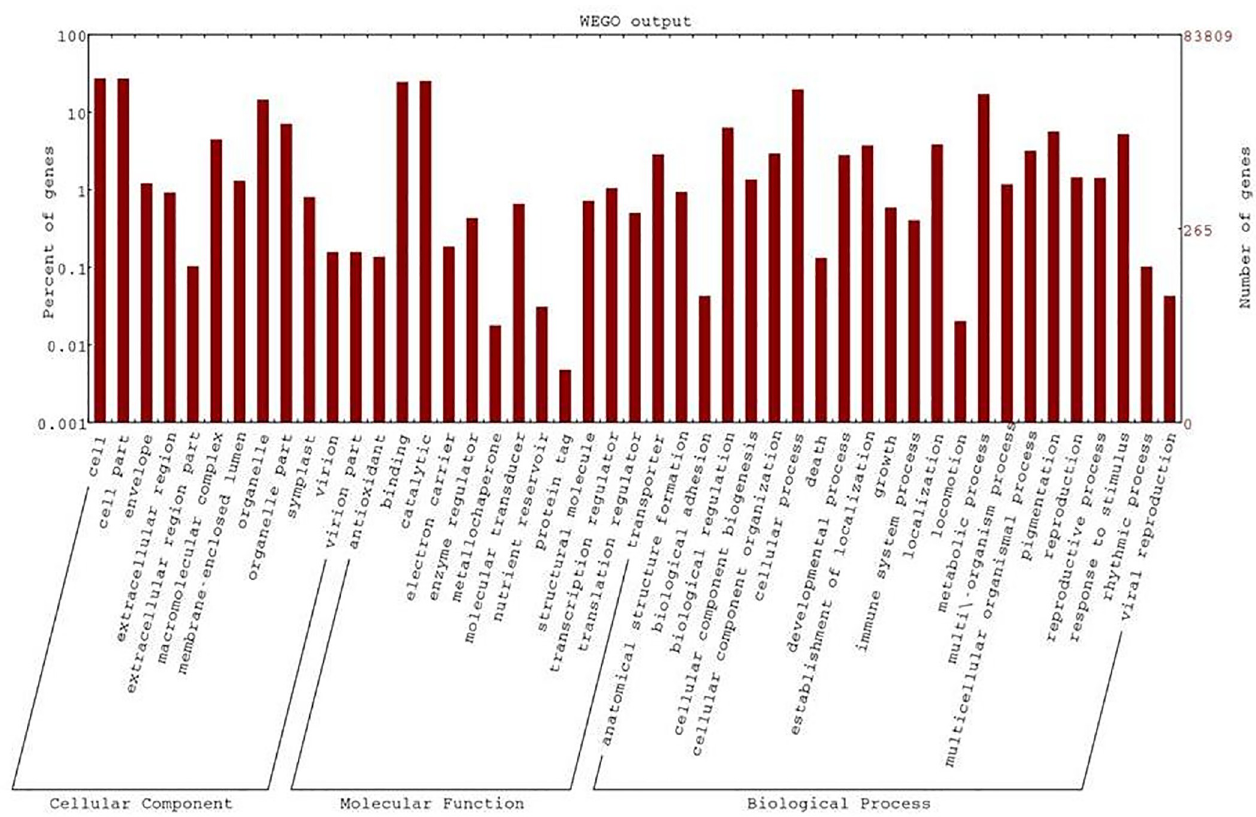
Fig 1. Functional classification of DE genes in Bandur and local